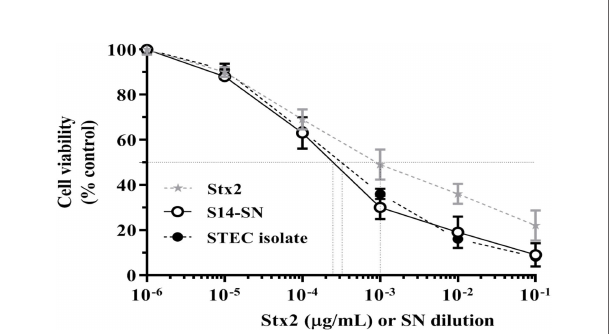
FIGURE 3 | Cytotoxic effects of STEC-positive endocervical samples on the viability of Swan 71 and HeLa cell lines. Cells were exposed to puri fi ed Stx2 or serial dilutions of the supernatant from endocervical sample S14 (S14-SN) for 72 h. Cell viability was analyzed by neutral red uptake. Data are shown as mean ± S.D from at least three independent experiments performed in triplicate. *p < 0.05 , n=3.